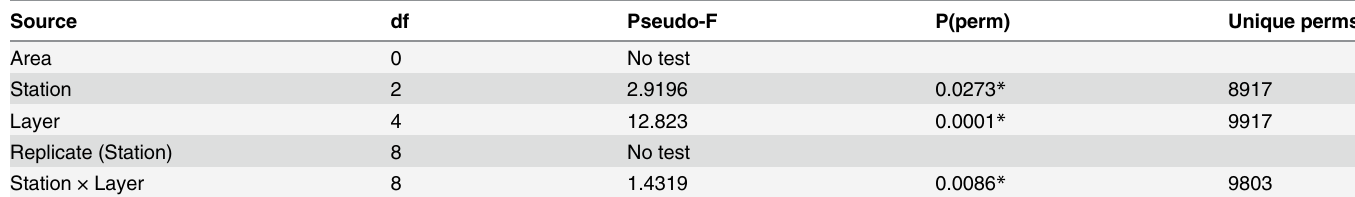
Table 4. PERMANOVA of nematode assemblages in Weddell Sea and Drake Passage (main test results). Asterisks represent significant